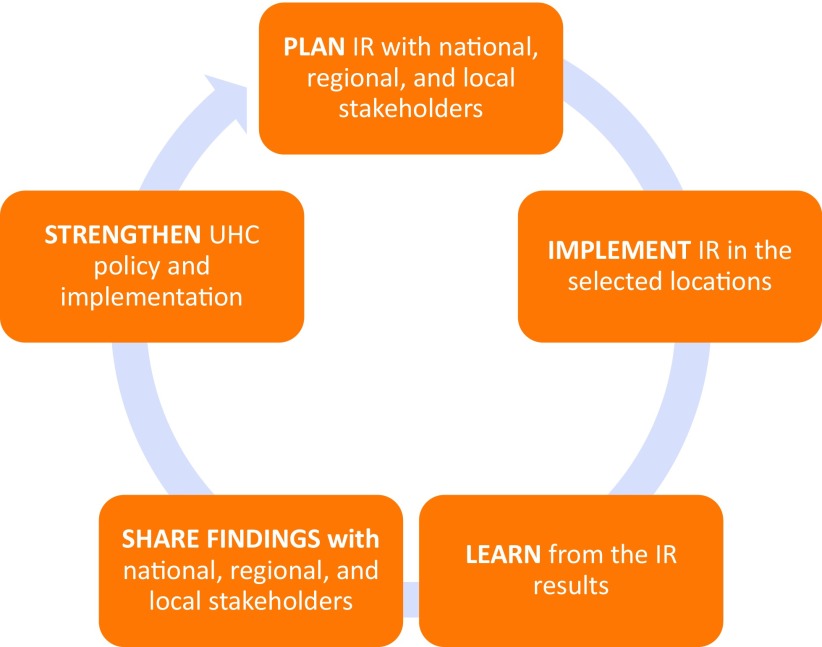
Implementation Research CycleAbbreviations: UHC, universal health care; IR, implementation research.